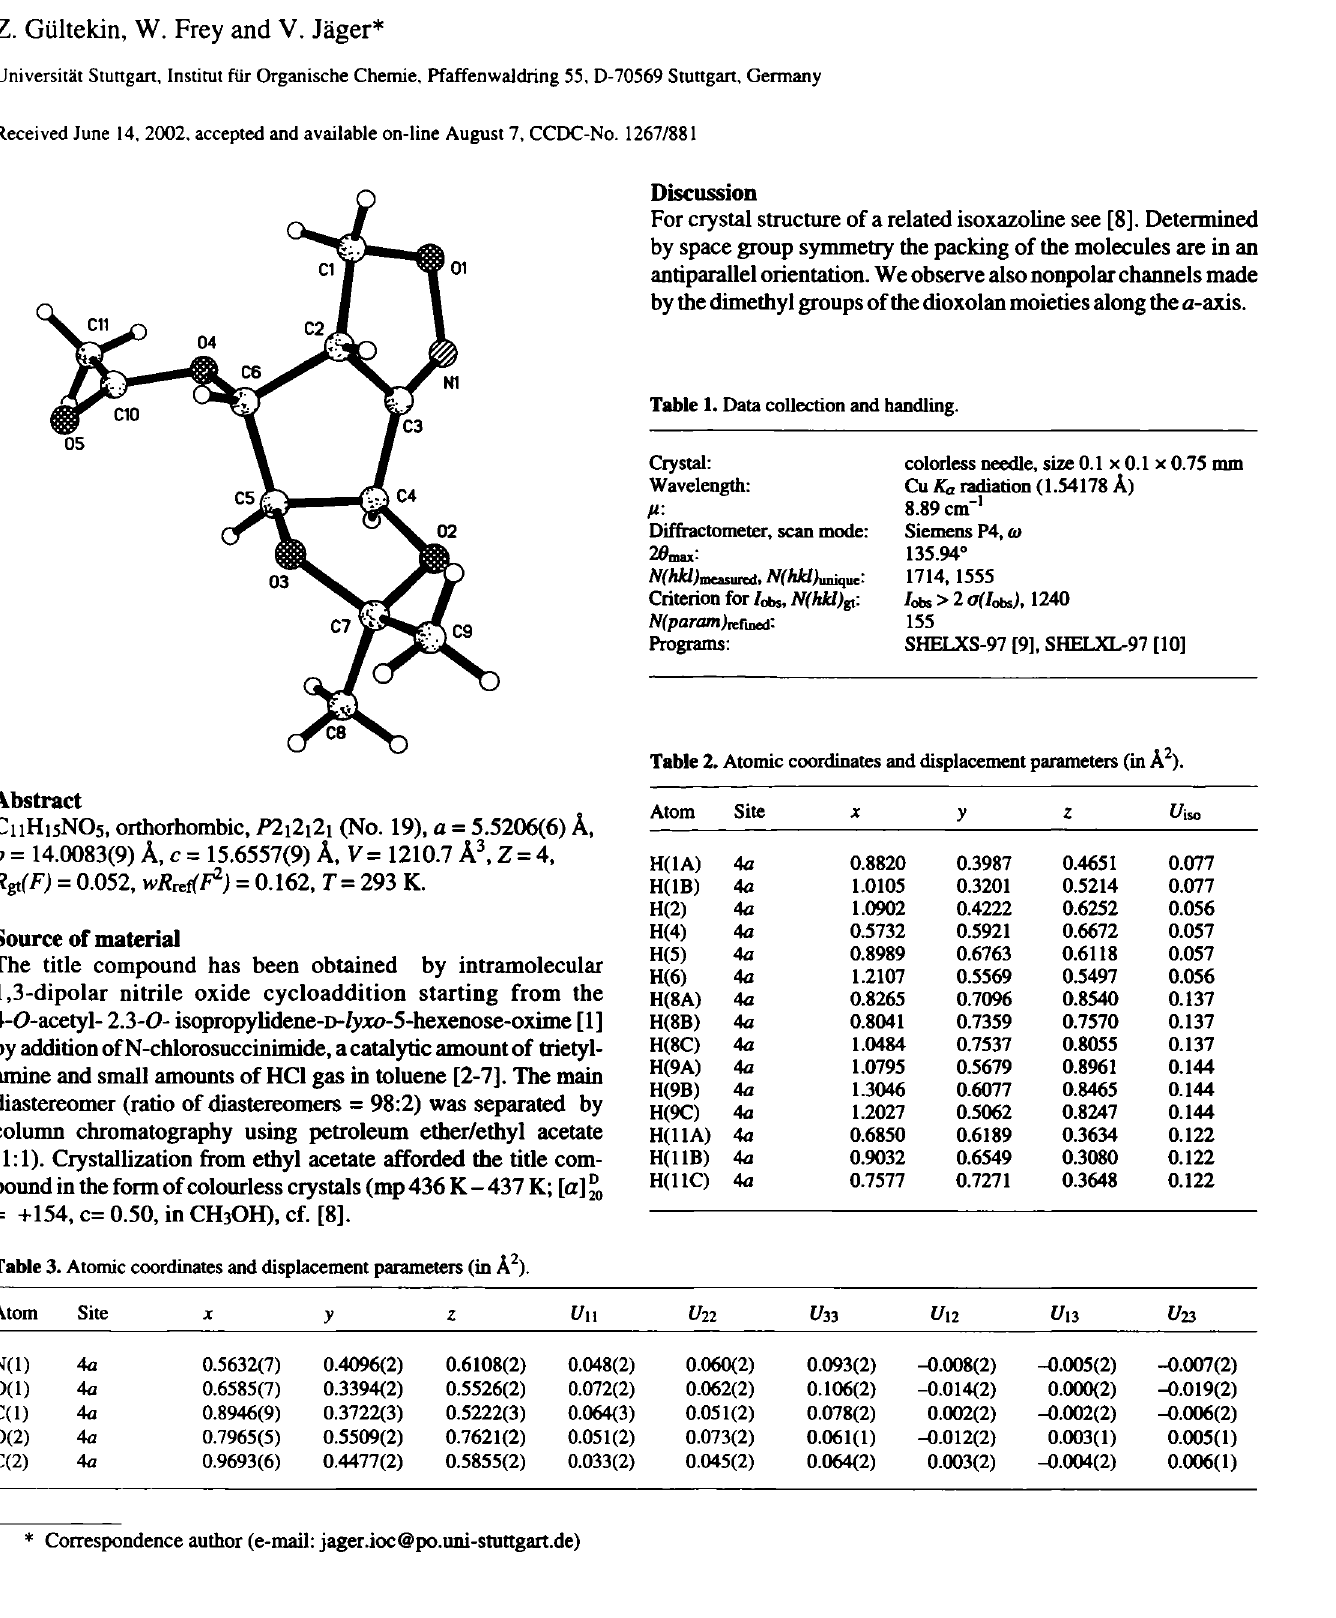
Table 3. Atomic coordinates and displacement parameters (in Â 2 ).